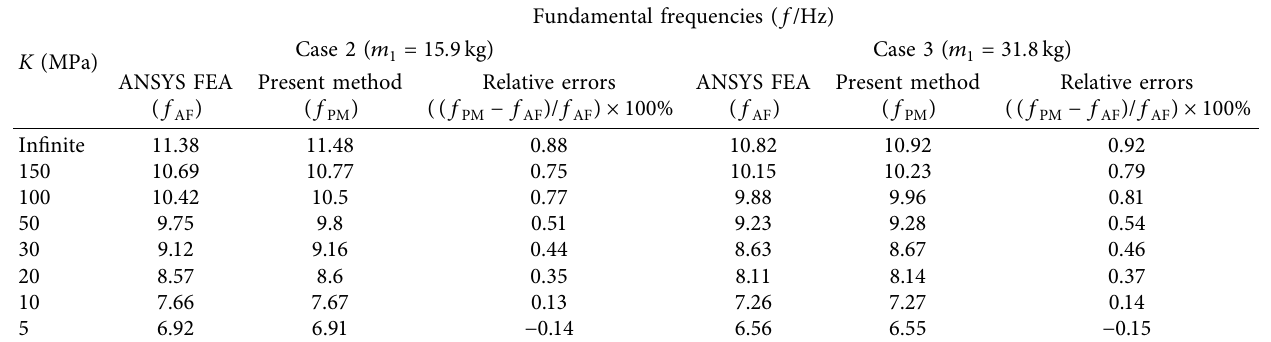
Table 3: A comparison of the fundamental frequencies for Case 2 and Case 3. K